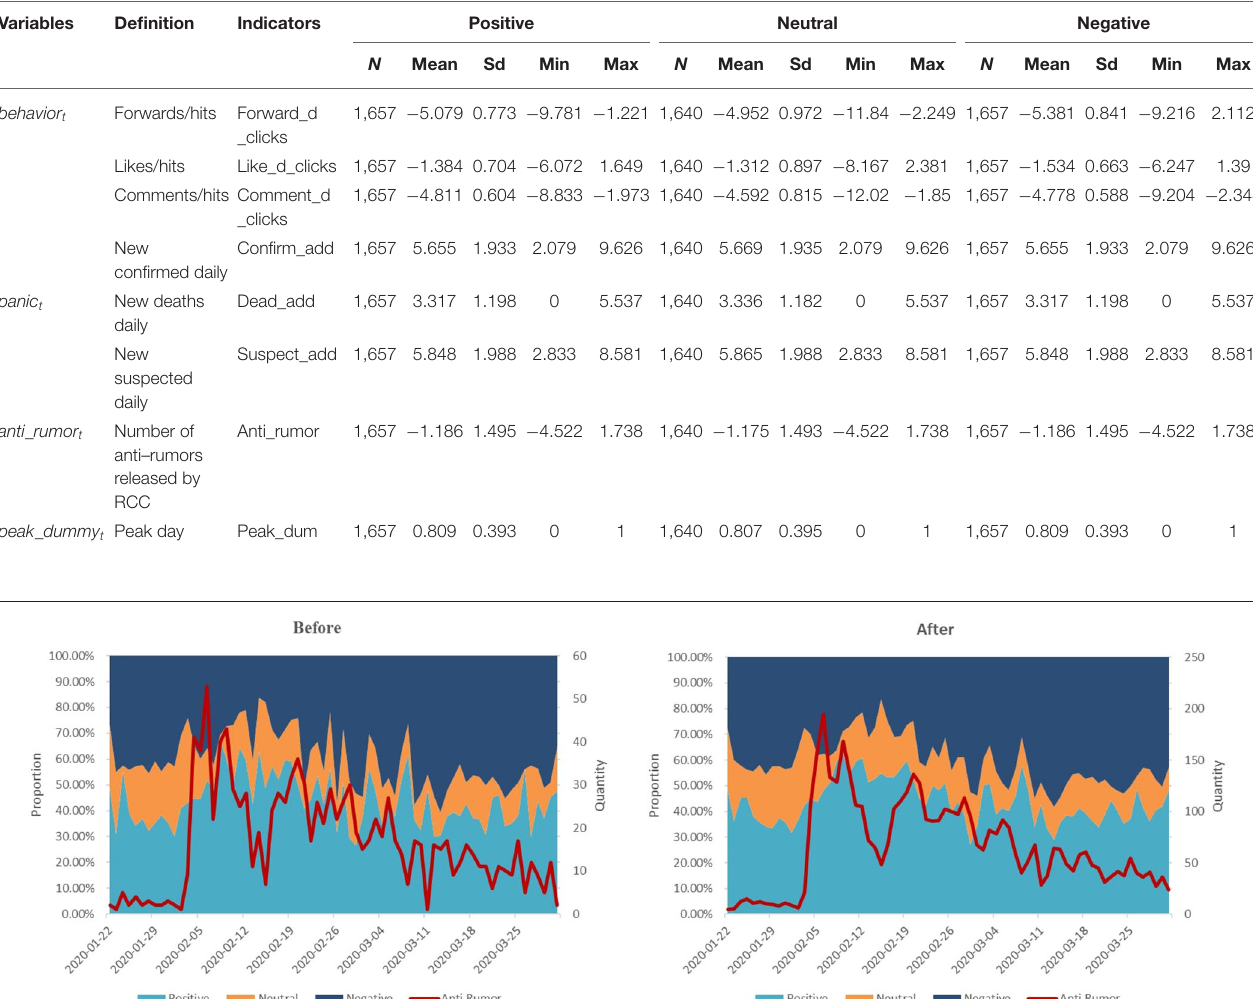
TABLE 1 | Variable definitions and statistical description.